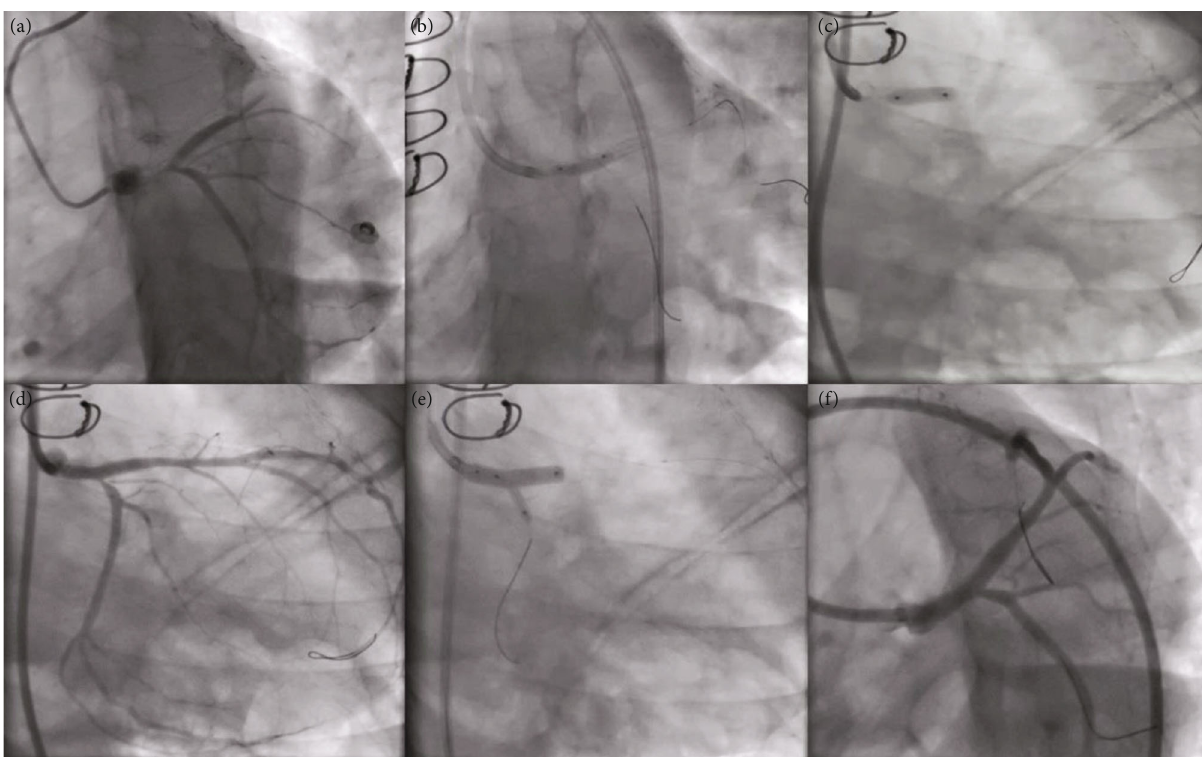
Figure 3: Angiographic images of repeat PCI. AP caudal view showed 95% ISR at proximal LMCA (a). Balloon dilatation of the lesion was done using 2 : 75 × 12 mm NC balloon and 3 × 10 mm cutting balloon (b, c). LCX ostium had critical narrowing after balloon dilatation (d), and hence, kissing balloon in fl ation (e) was done using 4 × 20 mm sirolimus eluting balloon (LMCA-LAD) and 2 : 75 × 12 mm NC balloon (LMCA-LCX). Final angiogram showed well expanded LMCA-LAD stent without residual stenosis